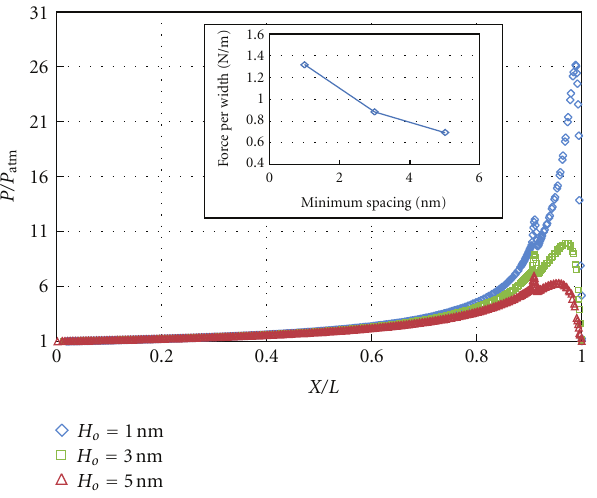
Figure 8: Comparison of air bearing pressure profiles on the slider surface with varied slider body temperatures for a fixed pitch angle ( α ) of 0.004